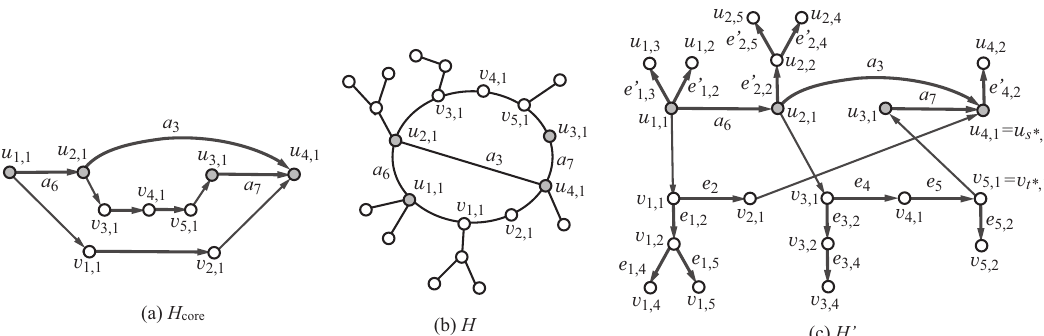
Figure 9. ( a ) An example of an extension of the scheme graph; ( b ) an example of a rank-2 graph H with n ( H ) = 21, cs ( H ) = 9, ch ( H ) = 2 and θ ( H ) = 1, where the labels of some vertices and edges indicate the corresponding vertices and edges in the ( t ∗ ,ch ∗ , d max ) -tree-extension for cs ∗ = cs ( H ) , ch ∗ = ch ( H ) , s ∗ = 4, t ∗ = cs ∗ − s ∗ and d max = 3; ( c ) a subgraph H (cid:48) of ( t ∗ = 5,ch ∗ = 2, d max = 3 ) -tree-extension isomorphic to the rank-2 graph H in ( b